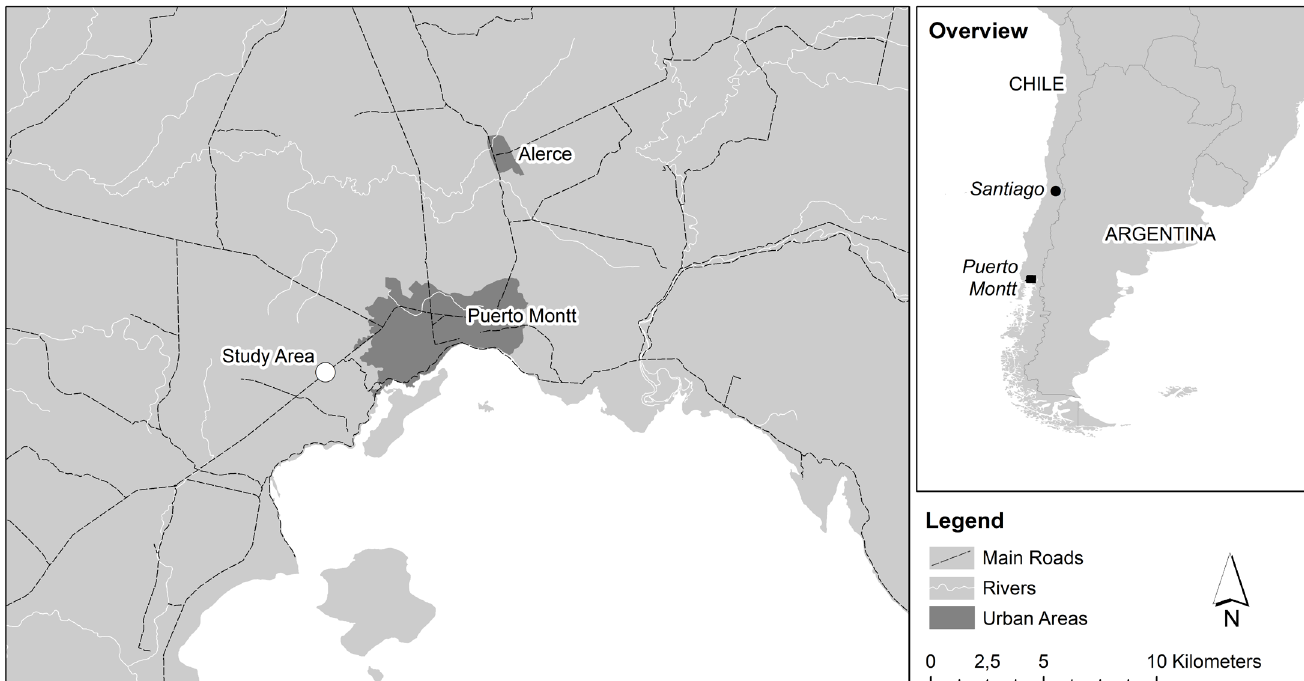
Figure 1: Location of the study area at Pargua Highway, Alto Bonito in Puerto Montt – Chile (Ruta 5 Sur Km